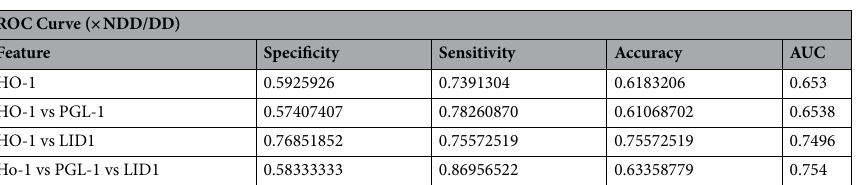
Table 1. Specificity, sensitivity and, accuracy of the use of ELISA of HO-1 to identify contacts more prone to develop leprosy. HO-1 = heme oxygenase 1, PGL-1 = Phenolic glycolipid, LID-1 (the fusion protein product of the ml0405 and ml2331